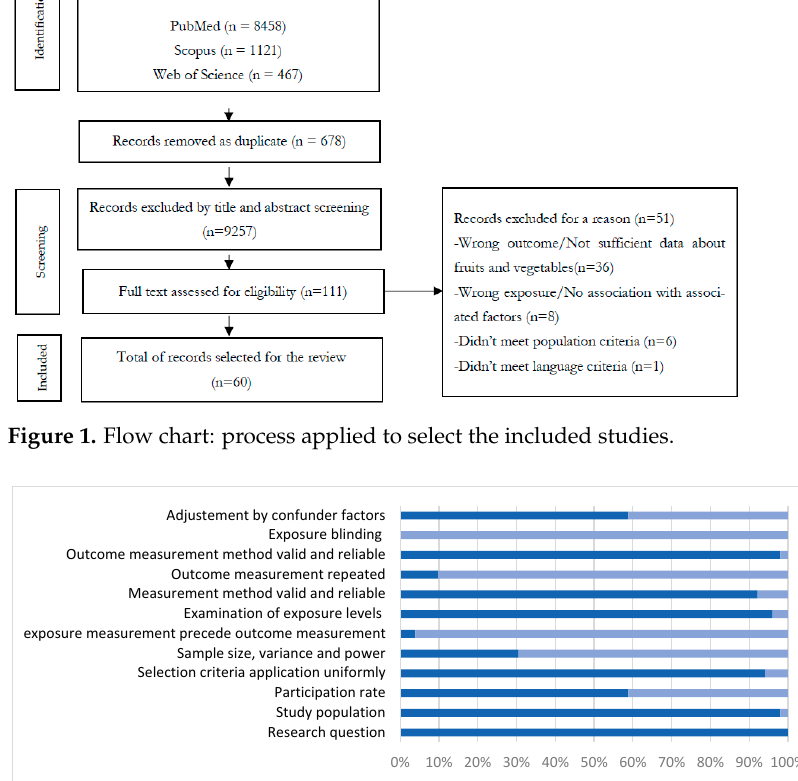
Figure 1. Flow chart: process applied to select the included studies.